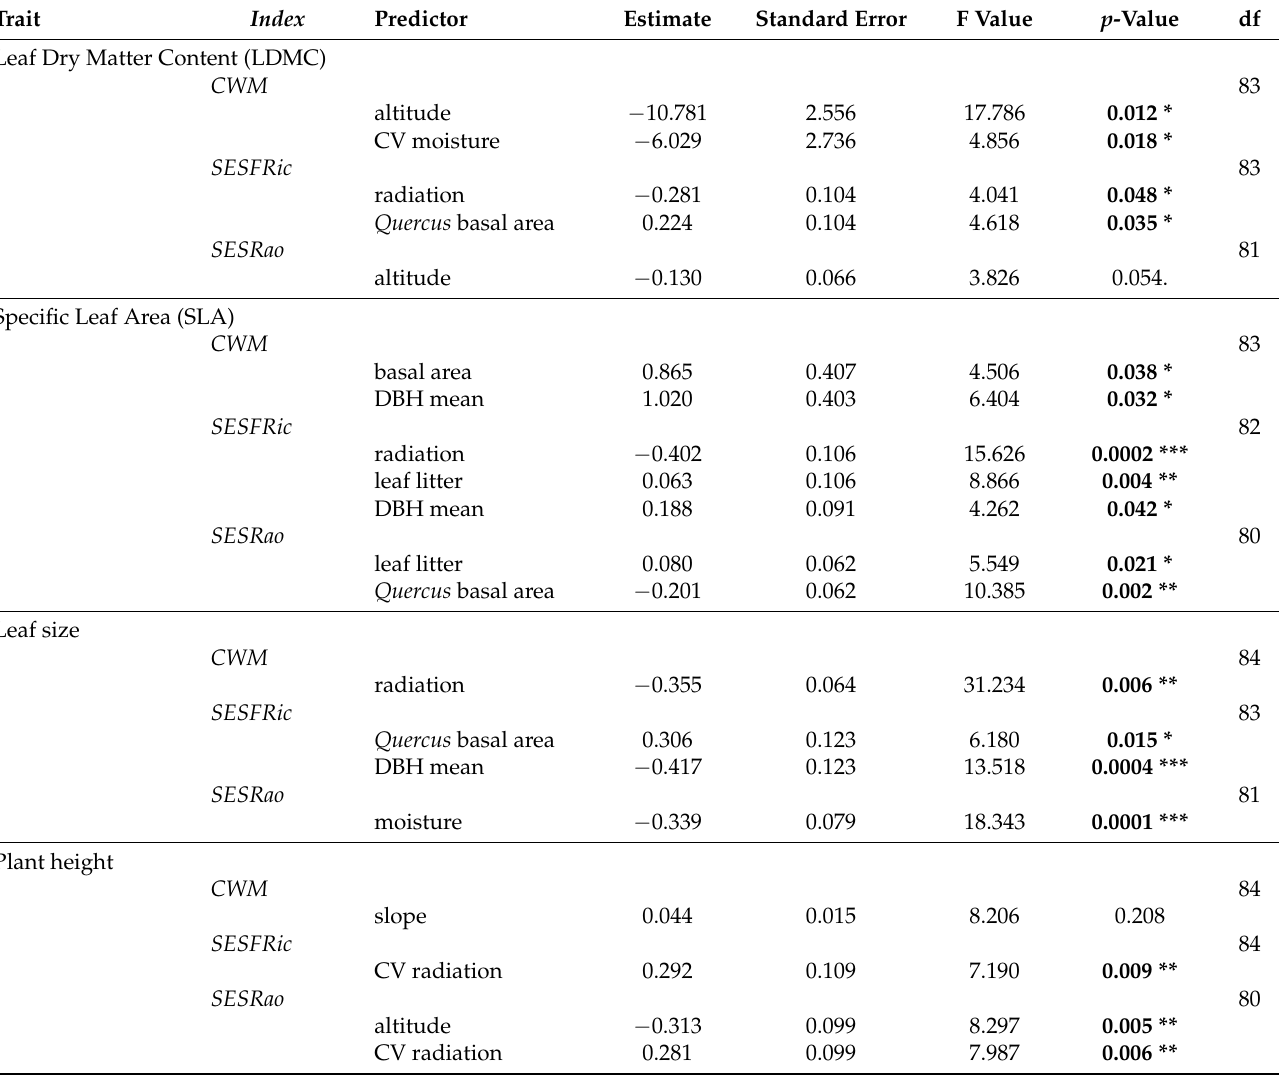
Table 1. Results of the selected linear regression models testing for relationships between functional composition (CWM), standardized effect size of functional richness (SESFRic), and diversity (SESRao) of the four traits that were studied (leaf dry matter content, specific leaf area, leaf size, and plant height), and environmental variables. The values that are presented in the table are the estimate with the standard error, the F value, the p -value that is associated with the F-test and the degrees of freedom of each model (df). Significant relationships ( p < 0.05) are highlighted in bold. ‘.’ = p >